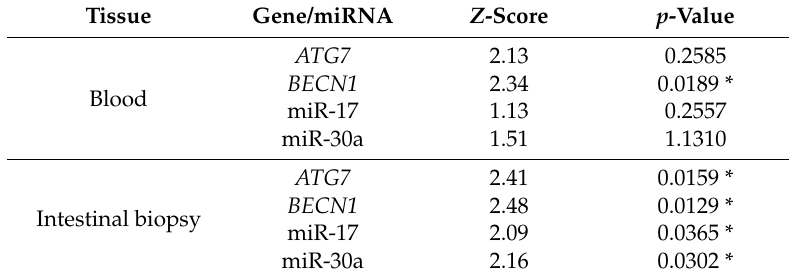
Table 1. Association of autophagy-related genes’ and miRNAs’ relative expression with CD status. Tissue Gene/miRNA Z -Score